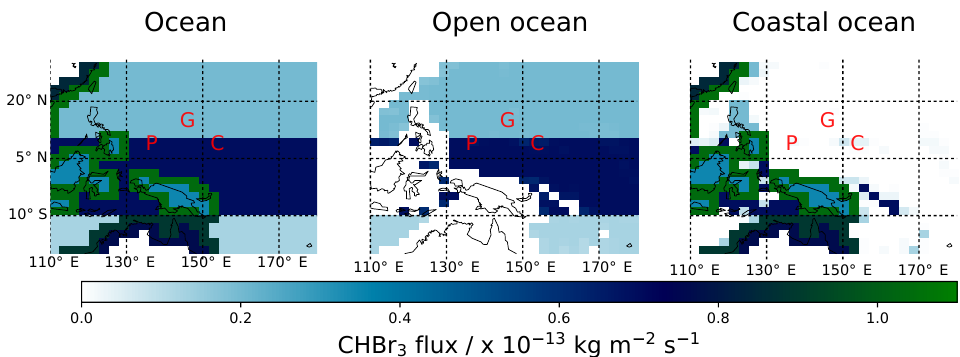
Figure 3. Flux of CHBr 3 from total, open, and coastal ocean tracers. Relevant island waypoints are shown inset: Guam (G), Palau (P), and Chuuk